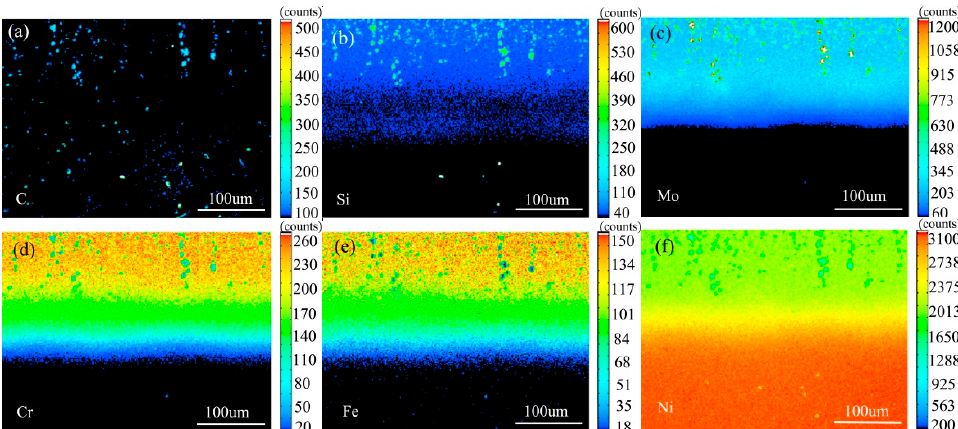
Figure 16. Composition distribution map of the diffusion couple sample of 2Si alloy and pure nickel after 1000 °C/200 h heat treatment: ( a ) C, ( b ) Si, ( c ) Mo, ( d ) Cr, ( e ) Fe, and ( f ) Ni.